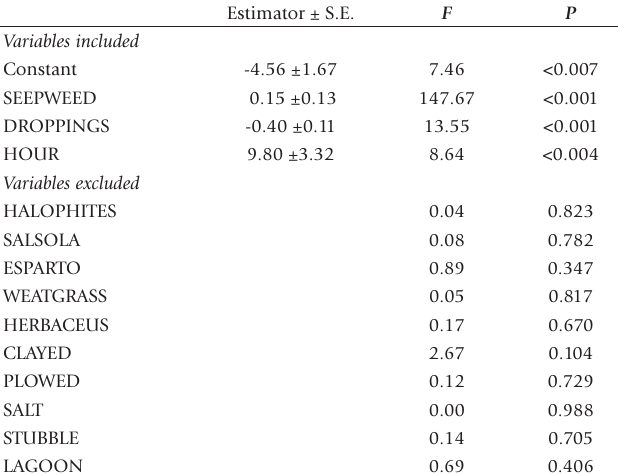
Table 2. Results of the forward stepwise multiple regression analy- sis for number of Mioscirtus wagneri /m 2 (ABUNDANCE) in rela- tion to the different explanatory variables analyzed.